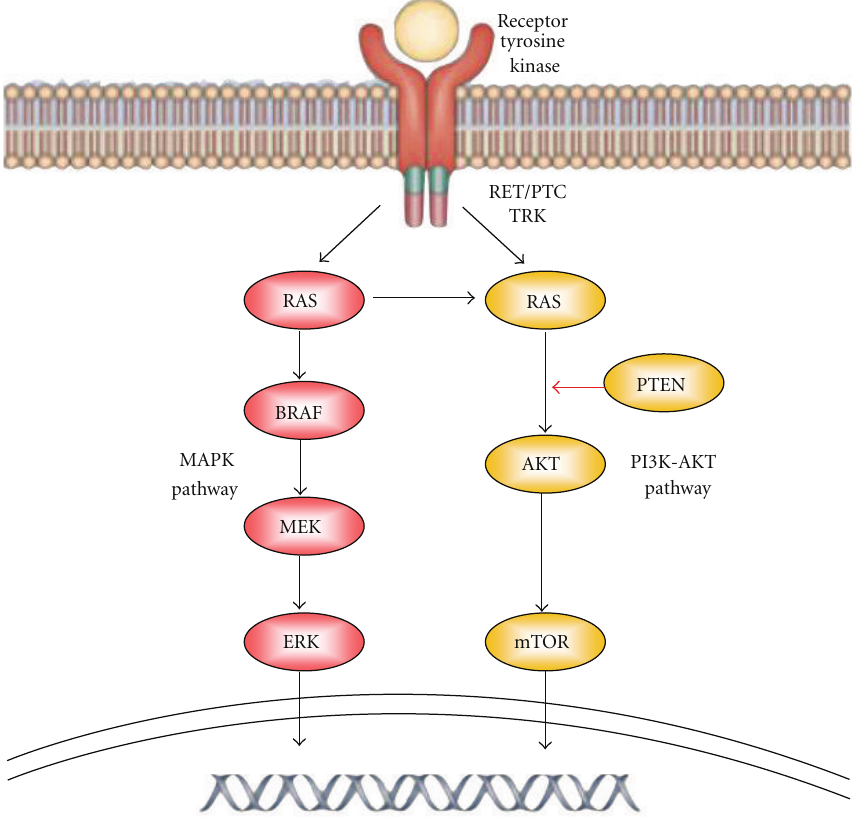
Figure 1: The main signaling pathways involved in thyroid carcinogenesis are the MAPK and PI3K-AKT pathway (reproduced with permission)